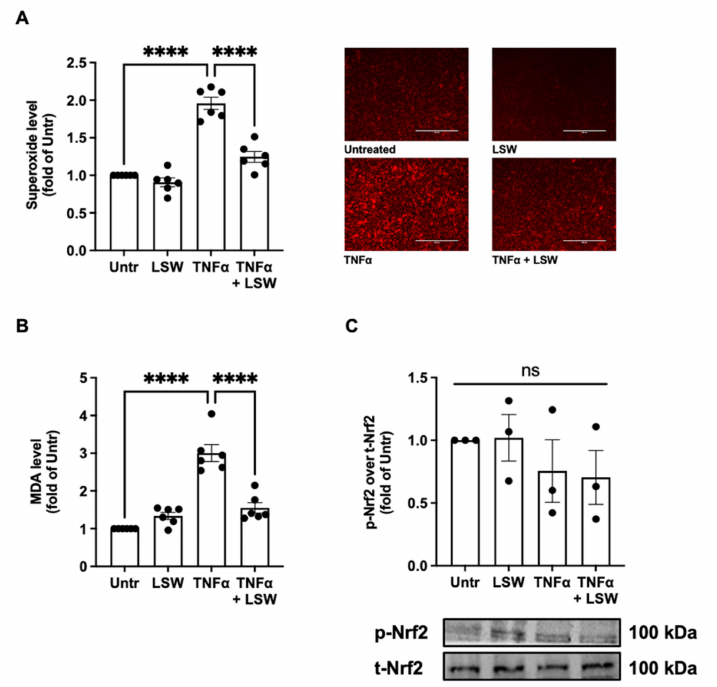
Figure 2. Effect of LSW treatment on TNF α -induced oxidative stress in EA.hy926 cells. The cells were treated with LSW (50 µ M) for 18 h before TNF α (10 ng/mL) stimulation for another 30 min followed by superoxide detection ( A ), or for another 6 h followed by malondialdehyde (MDA) measurement ( B ) and protein expression of Nrf2 ( C ). Protein bands of phosphorylated Nrf2 (p-Nrf2) were normalized to their total form (t-Nrf2). Data were normalized to the untreated group (Untr). ****, p < 0.0001; ns, not